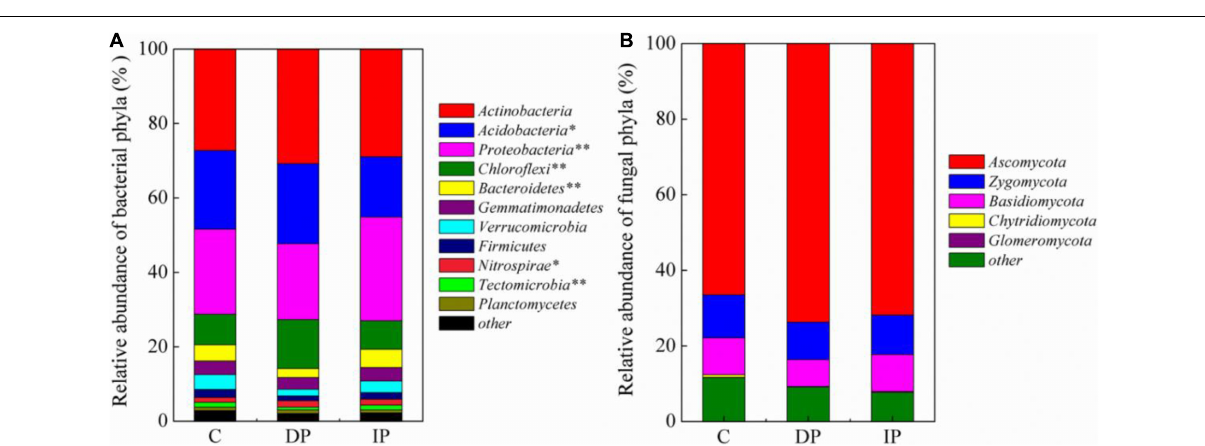
FIGURE 3 | The relative abundances of bacterial (A) and fungal (B) phyla in the soil samples. See Figure 1 for abbreviations. The value of p < 0.05 are marked “ ∗ ”, the value of p < 0.001 are marked “ ∗∗